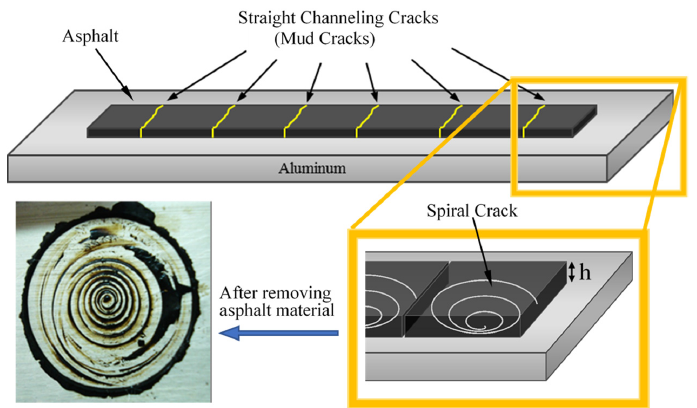
Figure 9. Asphalt binder showing the visible straight channeling cracks, i.e., mud cracks, and the spiral cracks that are only observed after the asphalt material is removed. The observed spiral cracks develop in each block due to the three ‐ dimension state ‐ of ‐ stress induced by the thermal mismatch between the asphalt blocks and the granite substrate.